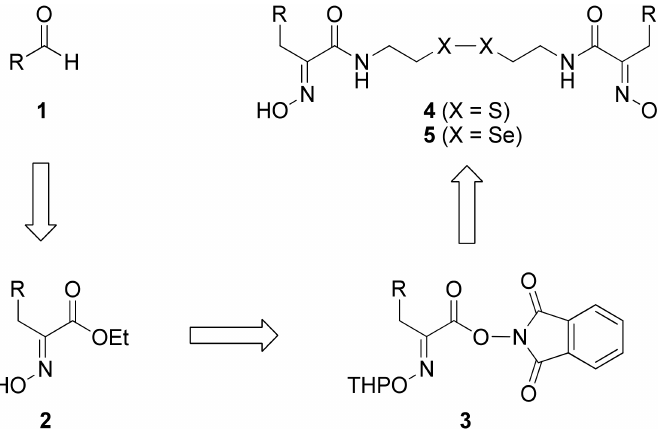
Figure 1. Established synthetic method of psammaplin A analog and selenopsammaplin A analog generation from aldehydes.